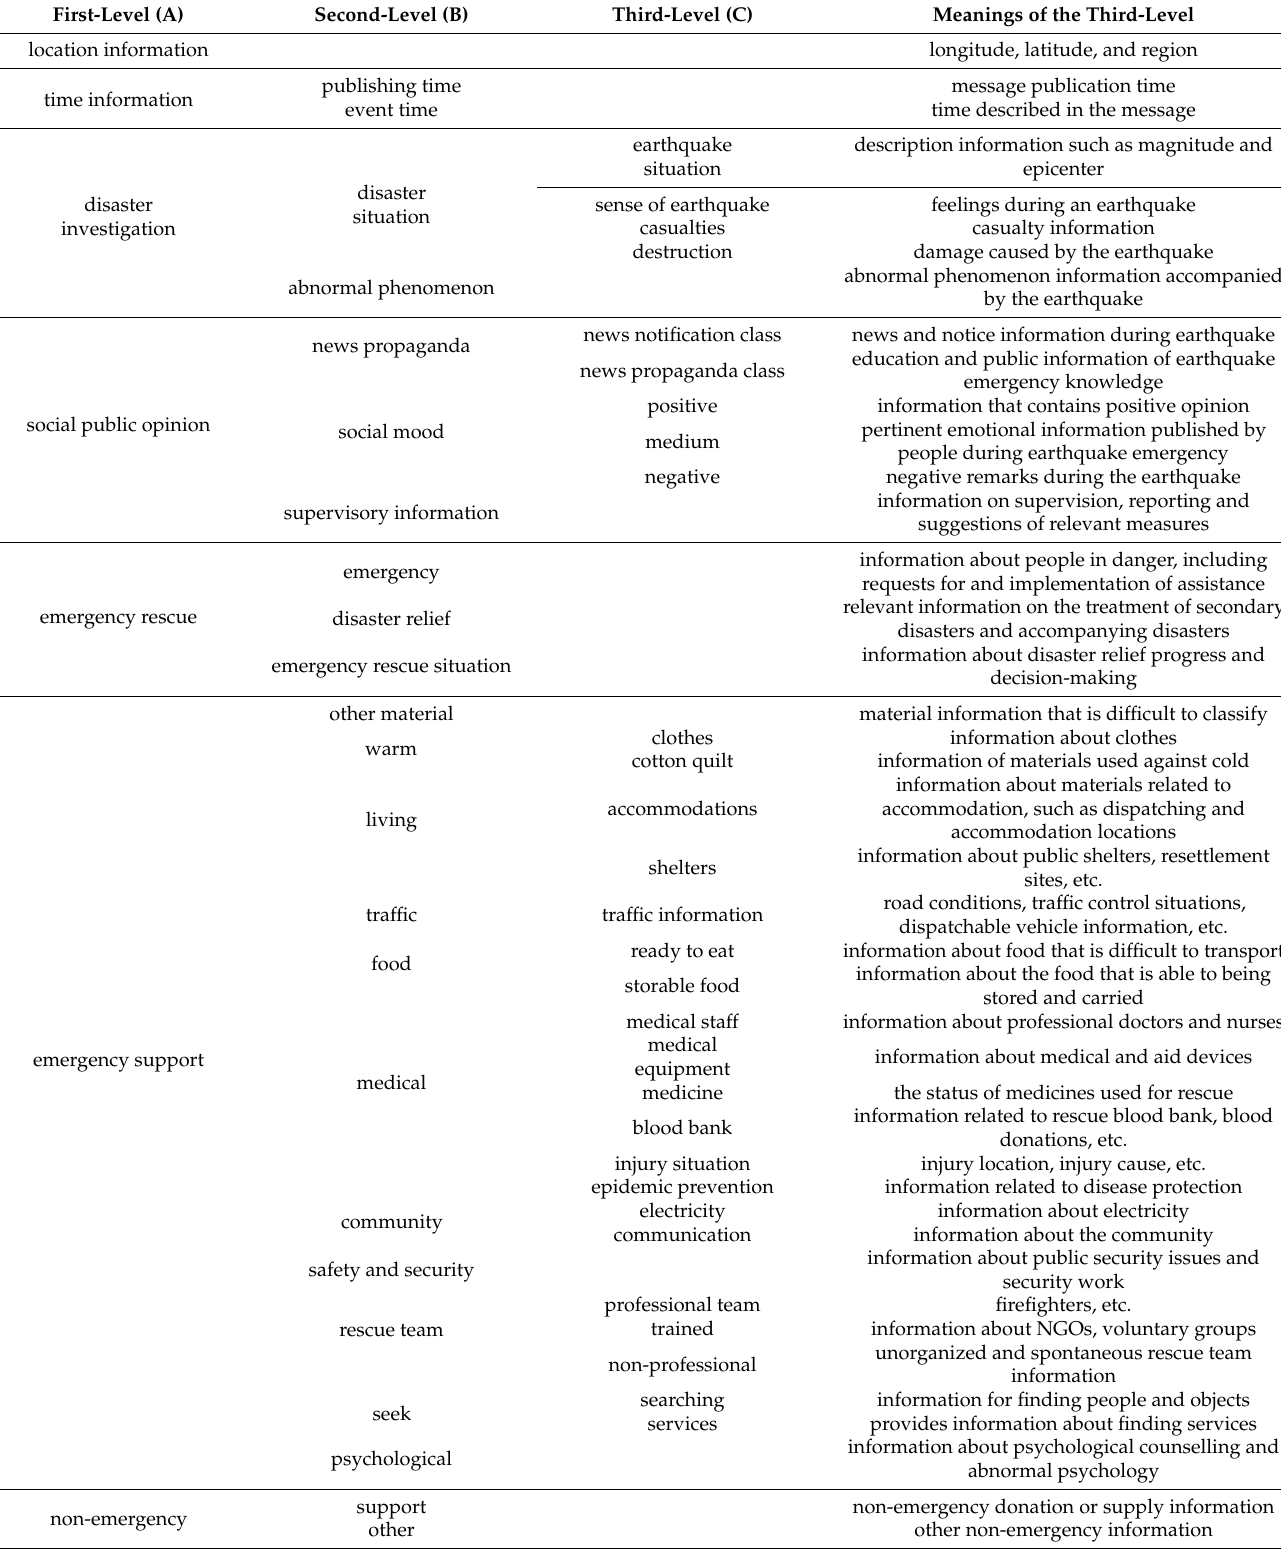
Table 3. Earthquake emergency information classification